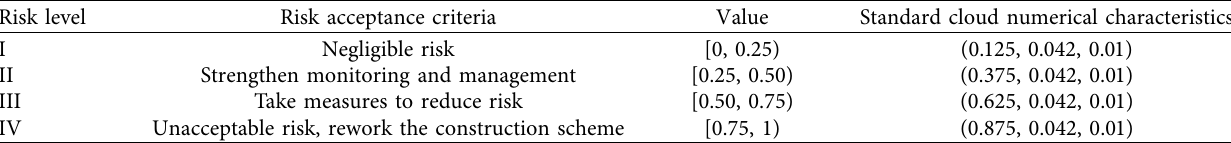
Table 2: The risk level criteria.